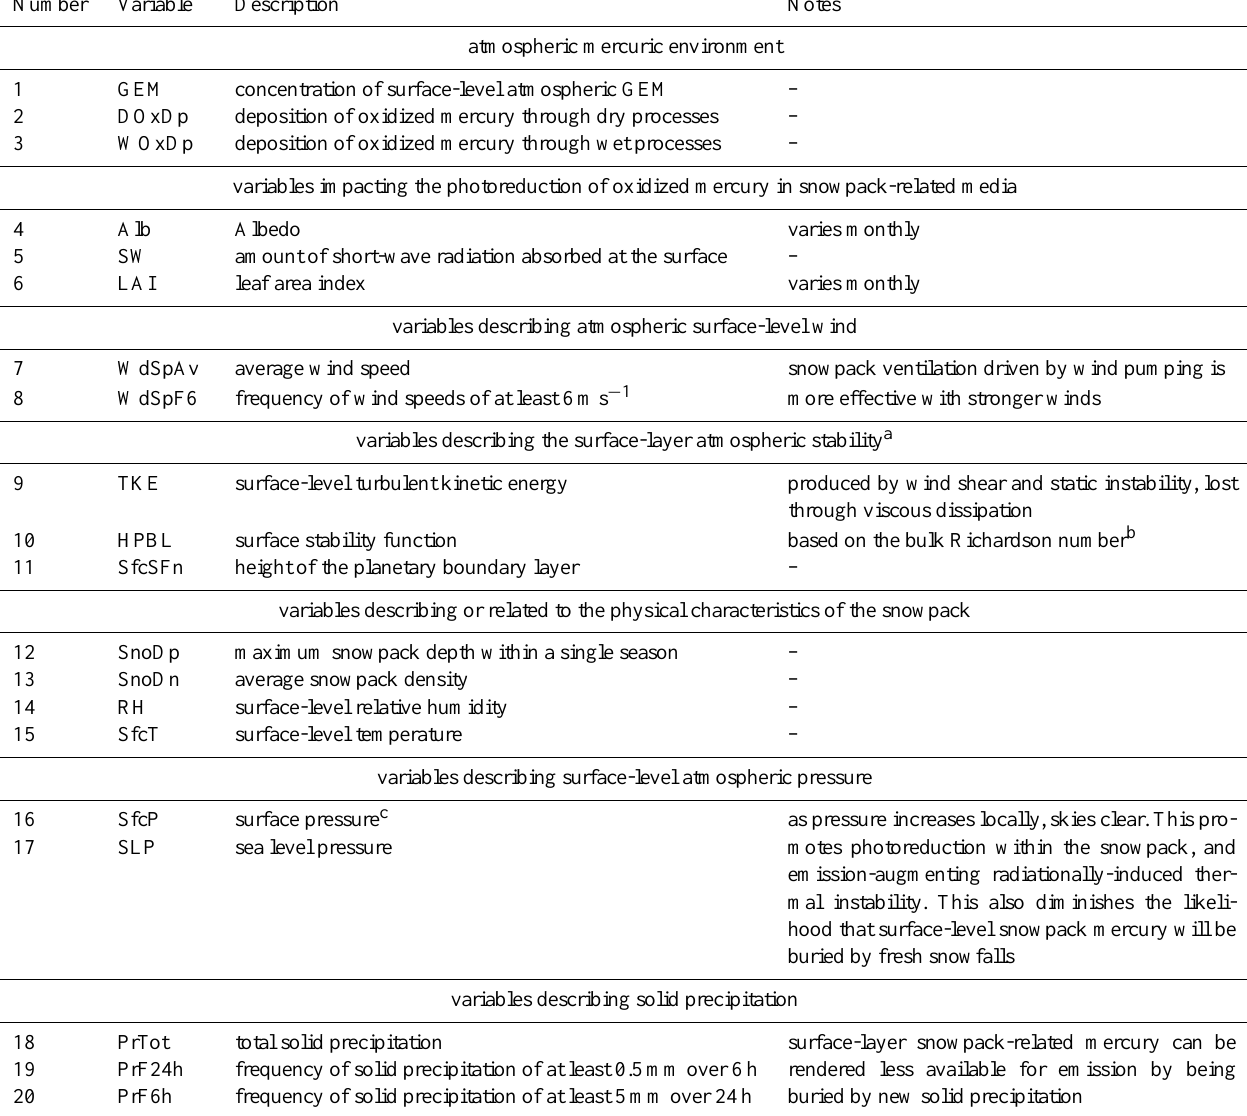
Table 7. Model environmental